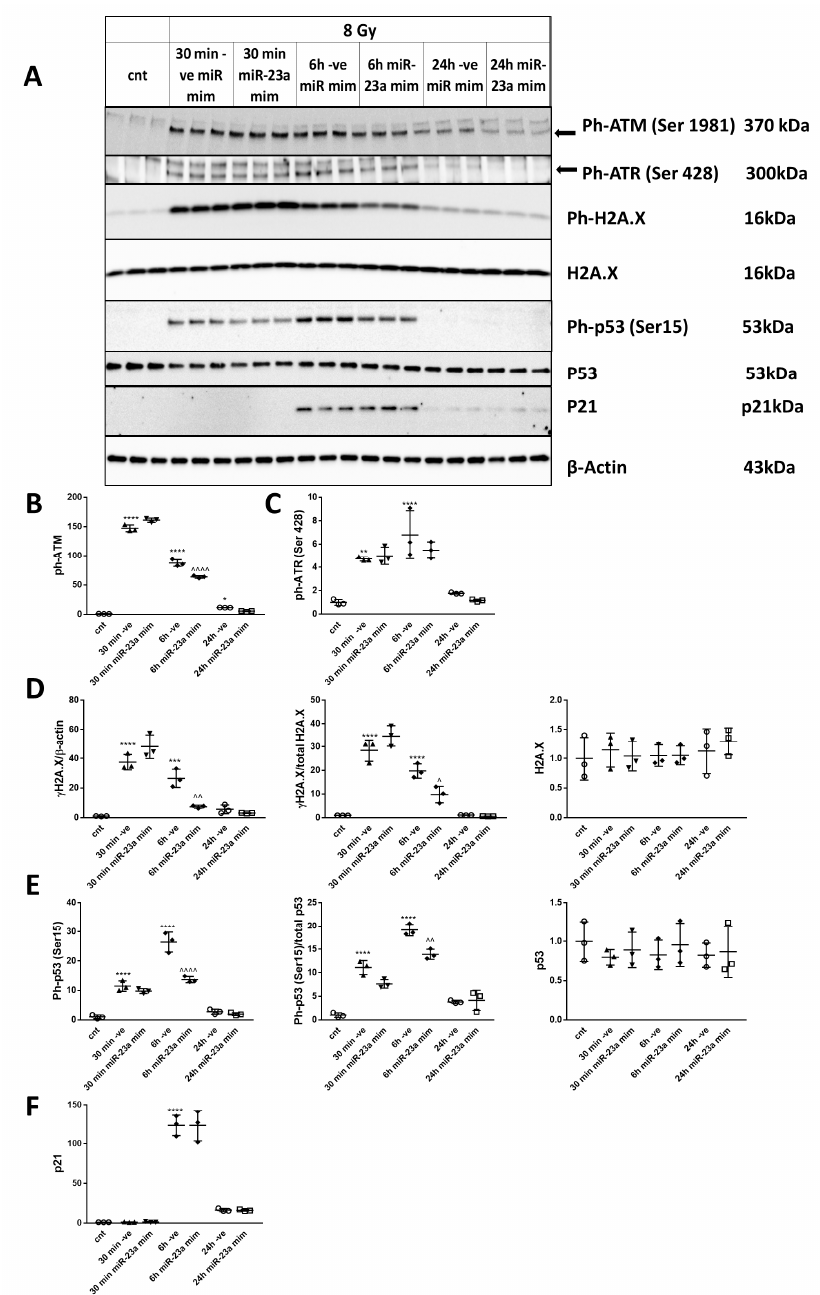
Figure 6. miR-23a-3p attenuates DNA damage response and p53 activation in primary cortical neurons following irradiation. RCNs were transfected with miR-23a-3p mimics, and negative control mimics before irradiation. Neurons were collected at 30 min, 6 h, and 24 h after 8 Gy irradiation. Whole-cell lysates were separated by SDS-polyacrylamide gel and immunoblotted with antibodies against Ph-ATM (Ser1981), Ph-ATR (Ser428) (approximately 300 kDa), γ -H2A.X (Ser139), H2A.X, Ph-p53 (Ser15), p53, p21 and β -actin (representative image). Image of a representative experiment ( A ). Protein levels were quantified by densitometry, normalized to β -actin and the parent proteins for γ -H2A.X and Ph-p53, and presented as fold change compared with untreated control levels ( B – F ). The experiment was repeated 3 times with similar results, n = 3 / group in each experiment. Data represent mean ± SD. Statistical significance assigned by one-way ANOVA and Tukey post-hoc analysis, * p < 0.05, ** p < 0.01, *** p < 0.001, **** p < 0.0001 vs. control RCN, ˆˆ p < 0.01, ˆˆˆˆ p < 0.0001 vs. negative control mimic transfected cells (-ve mim)